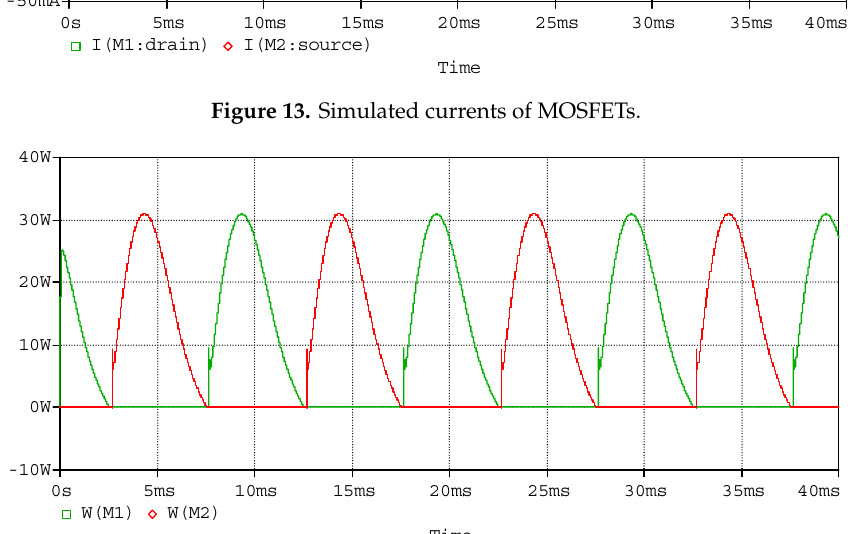
Figure 14. Simulated power consumptions of the MOSFETs.